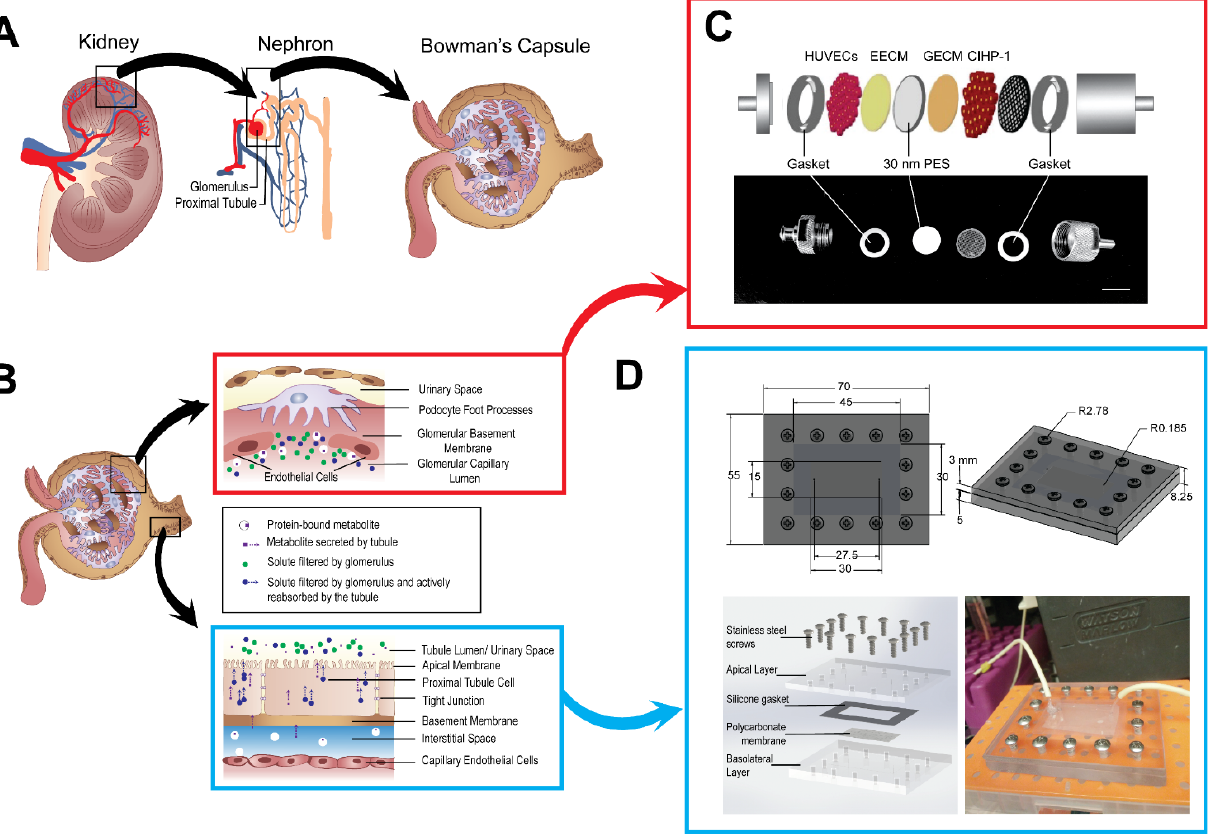
Figure 1. Translation of the nephron into MPS. ( A , B ) Schematic of kidney, nephron, and its structures. ( C ) Schematic and image of glomerulus housing unit. Bar = 12 mm. ( D ) Schematic and image of PCT device.